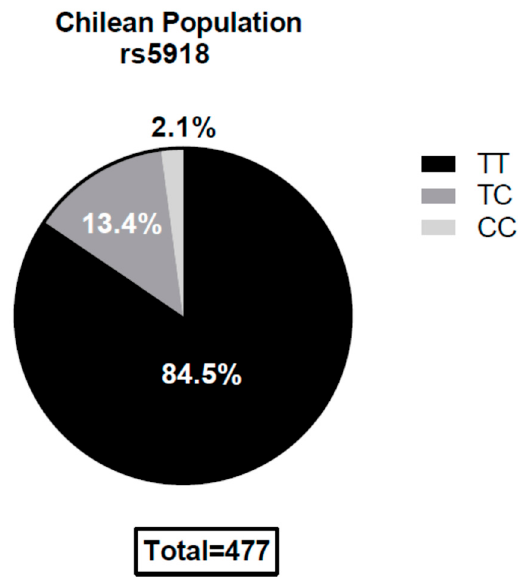
Figure 1. Single Nucleotide Polymorphism (SNP) rs5918 genotype distribution within the Chilean population. The TT genotype is the homozygous allele that codes for leucine at the 33rd position of the plexin–semaphorin–integrin (PSI) integrin domain. The CC genotype is the homozygous allele that codes for a proline at the same position, dramatically reducing Andes Orthohantavirus (ANDV) recognition in ex vivo models (14). The SNPs were in the Hardy–Weinberg equilibrium ( p > 0.05).